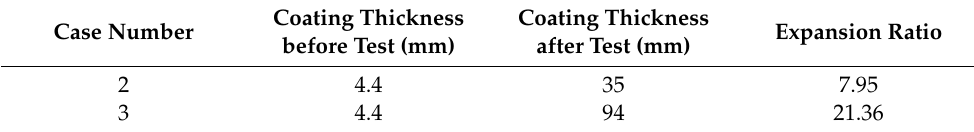
Table 5. Thickness statistics of IFC before and after the test.